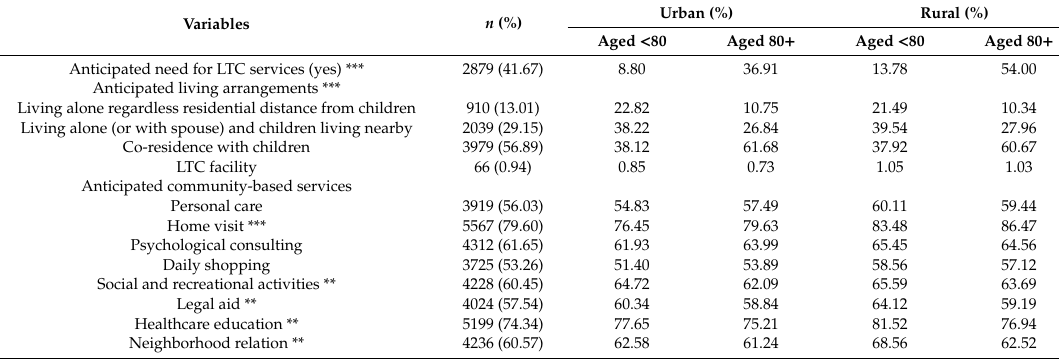
Table 3. LTC service needs by age cohort and residence.